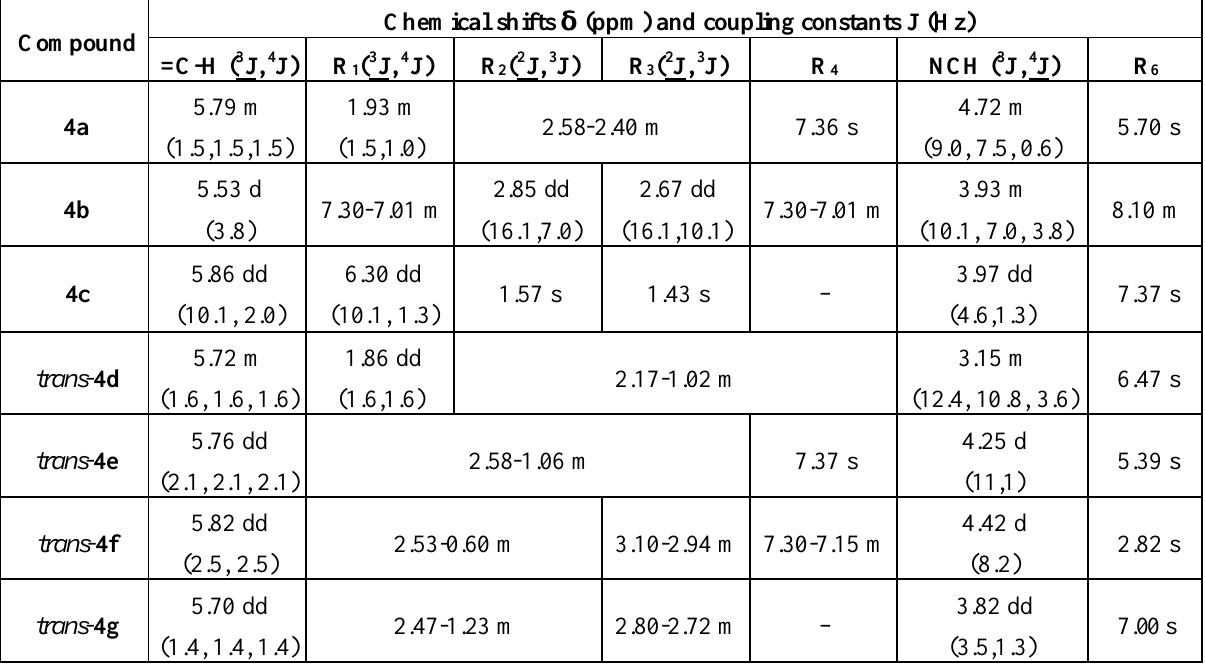
Table 2. 1 H-NMR Data of Compounds 4a-g